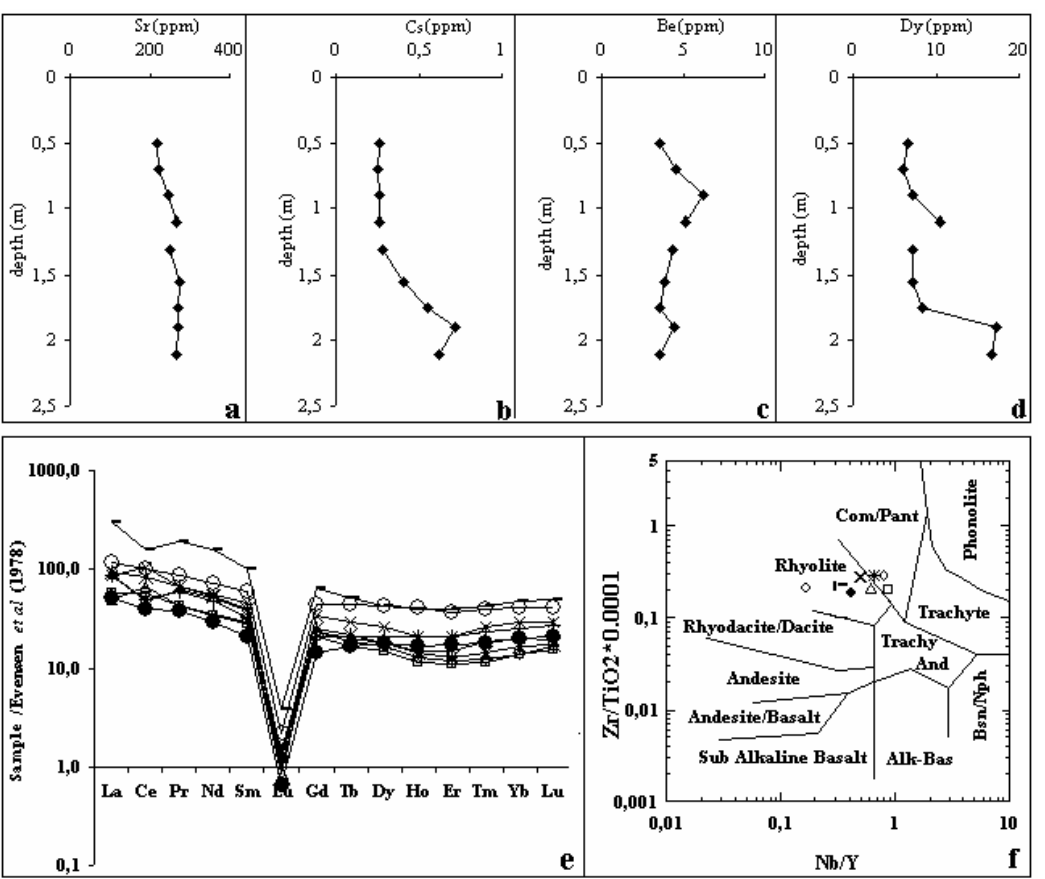
Fig. 4 – Trace and REE elements. The variations of trace element amounts vs depth are given for four representative elements: a) Sr for group 1 (identical concentrations in the lower and upper layers: Co, Ga, Hf, Nb, Rb, Sn, Sr, Ta, Th, Zr); b) Cs for group 2 (higher concentrations in the bottom layer: Cs, Cu, Ge, In, Pb, U, Zn); c) Be for group 3 (higher concentrations in the upper layer: Ba, Be); d) Dy for group 4 (identical patterns with larger variation range in the bottom layer: Ce, Dy, Er, Eu, Gd, Ho, La, Lu, Nd, Pr, Sb, Sm, Tb, Tm, Y, Yb), e) REE patterns of bentonite samples normalized to CI chondrite (Evensen 1978). f) Position of the bentonite samples in the diagram of Winchester and Floyd